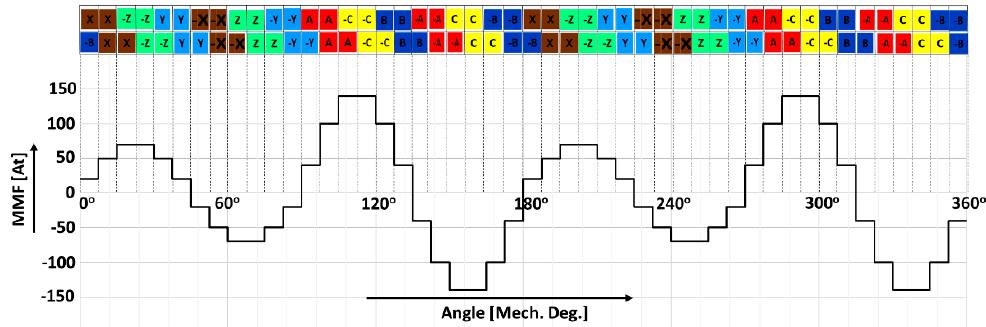
Figure 2. Magnetomotive force (MMF) plot of the eight ‐ pole, 48 ‐ slot stator winding.